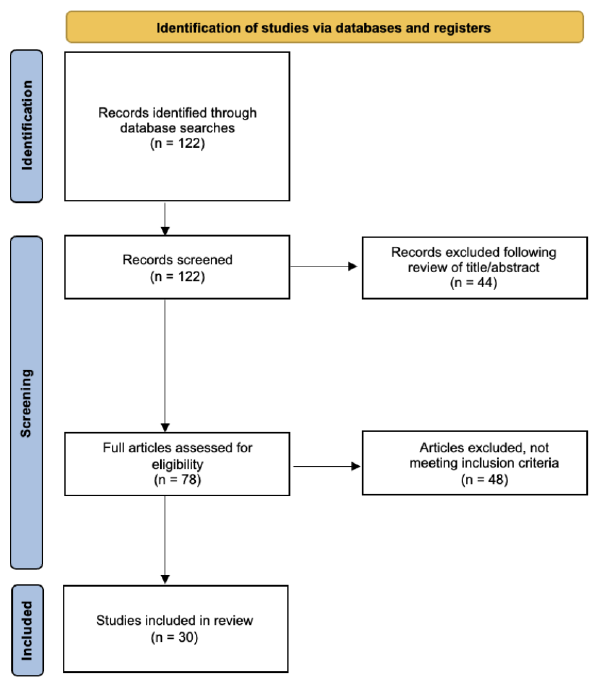
Figure 1. Results of the literature screening process.